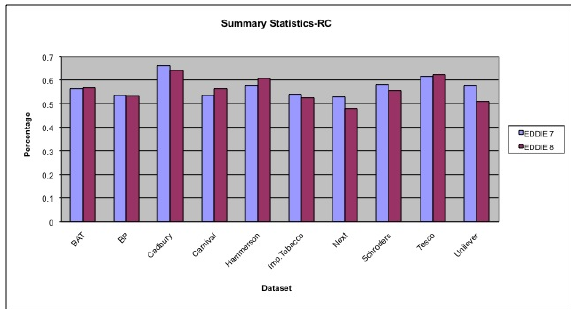
Figure 6 Summary results over 50 runs for fitness for ED- DIE 7 and EDDIE 8. Results are normalized to [0,1] scale.